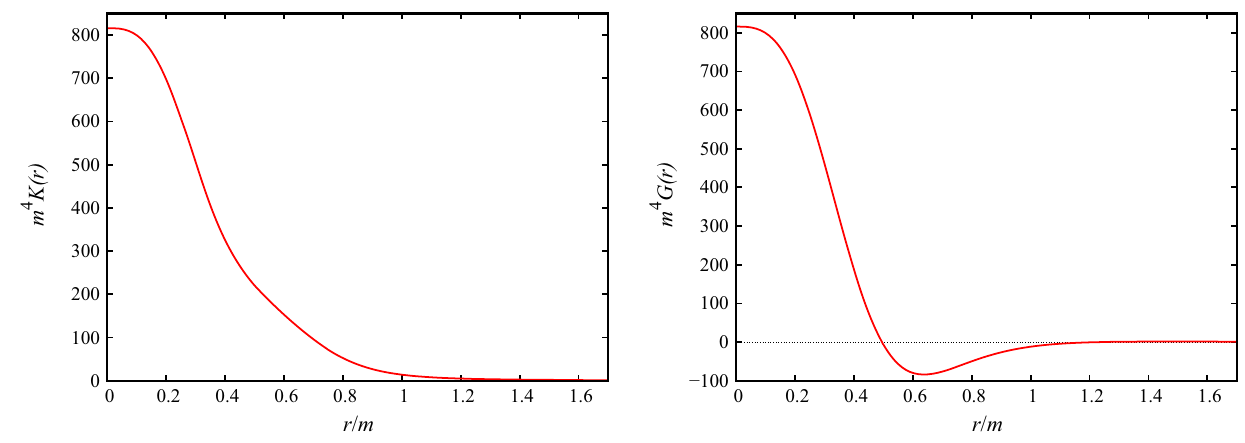
Fig. 7 Kretschmann scalar and Gauss–Bonnet invariant in terms of the radial coordinate for q = 0 . 7 m